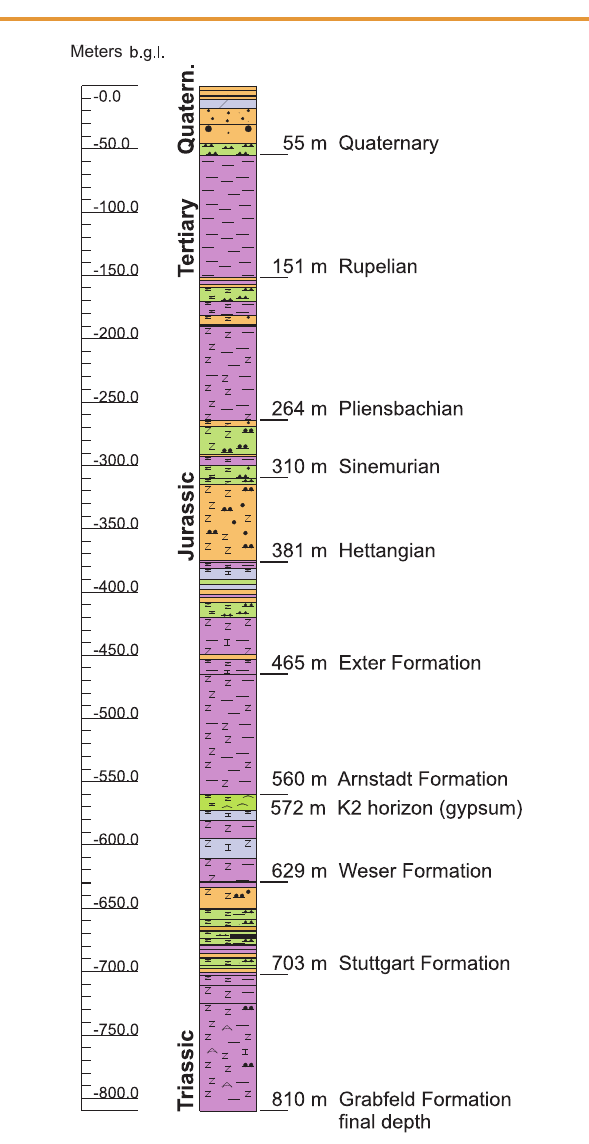
TS-8Figure 3. Condensed geological profile of the Ktzi 200/2007 borehole. Lithological color code: mudstone (magenta), siltstone (green), sandstone (yellow), anhydrite (light